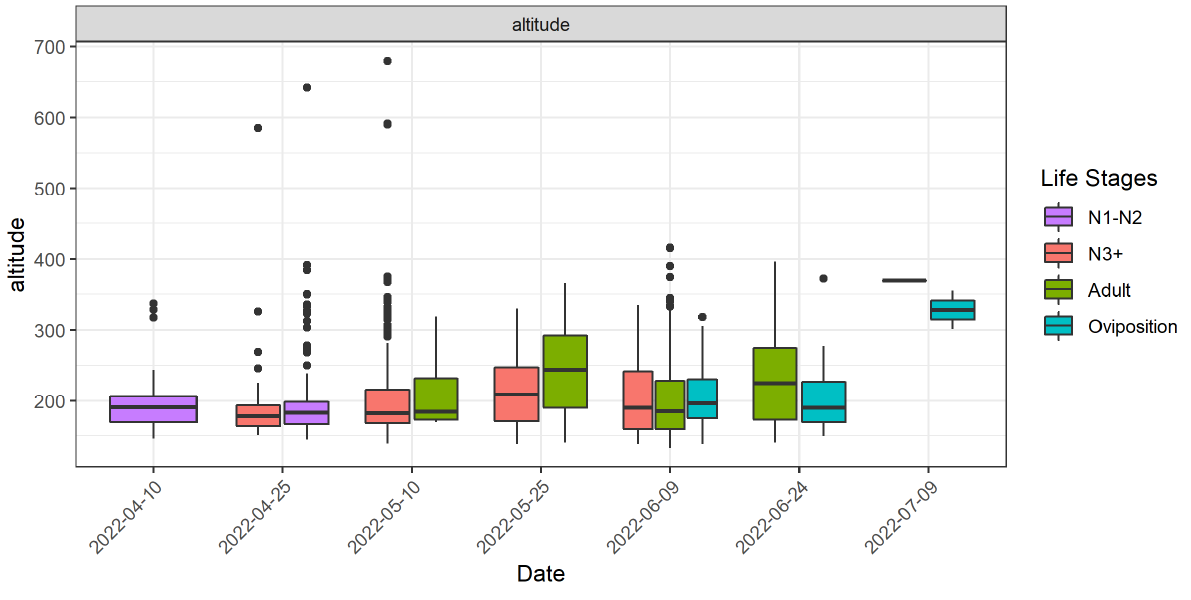
Figure 9. Relation between elevation and time for different stages of detected DMA locations between April and July 2022.